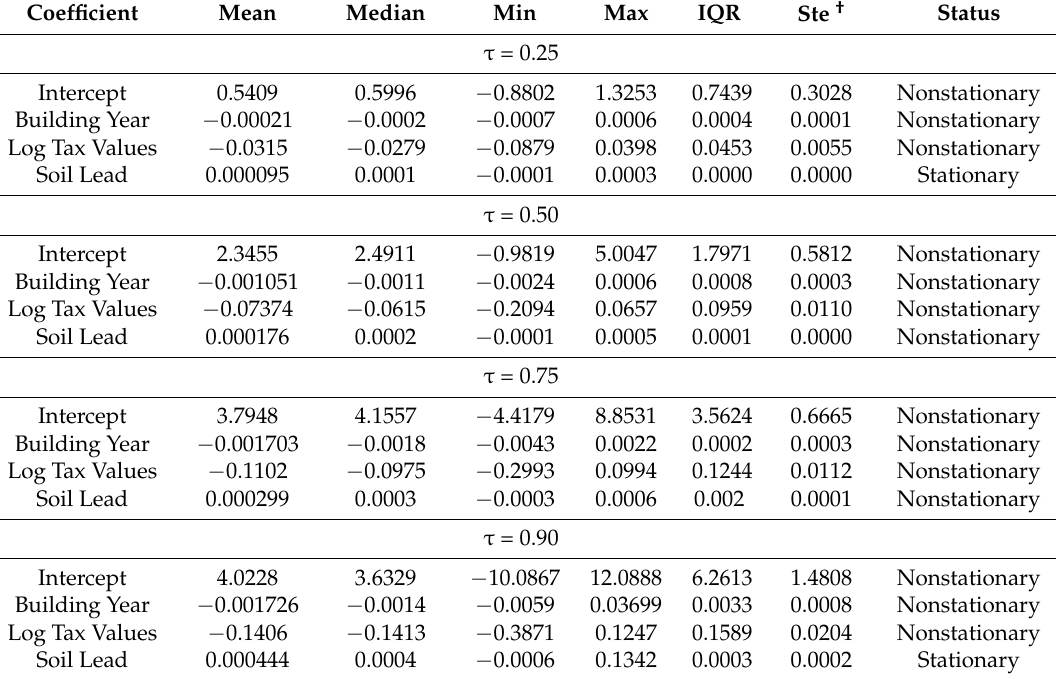
Table 5. Summary of parameter estimates of GWQR models for τ = 25, 50, 75 and 90.